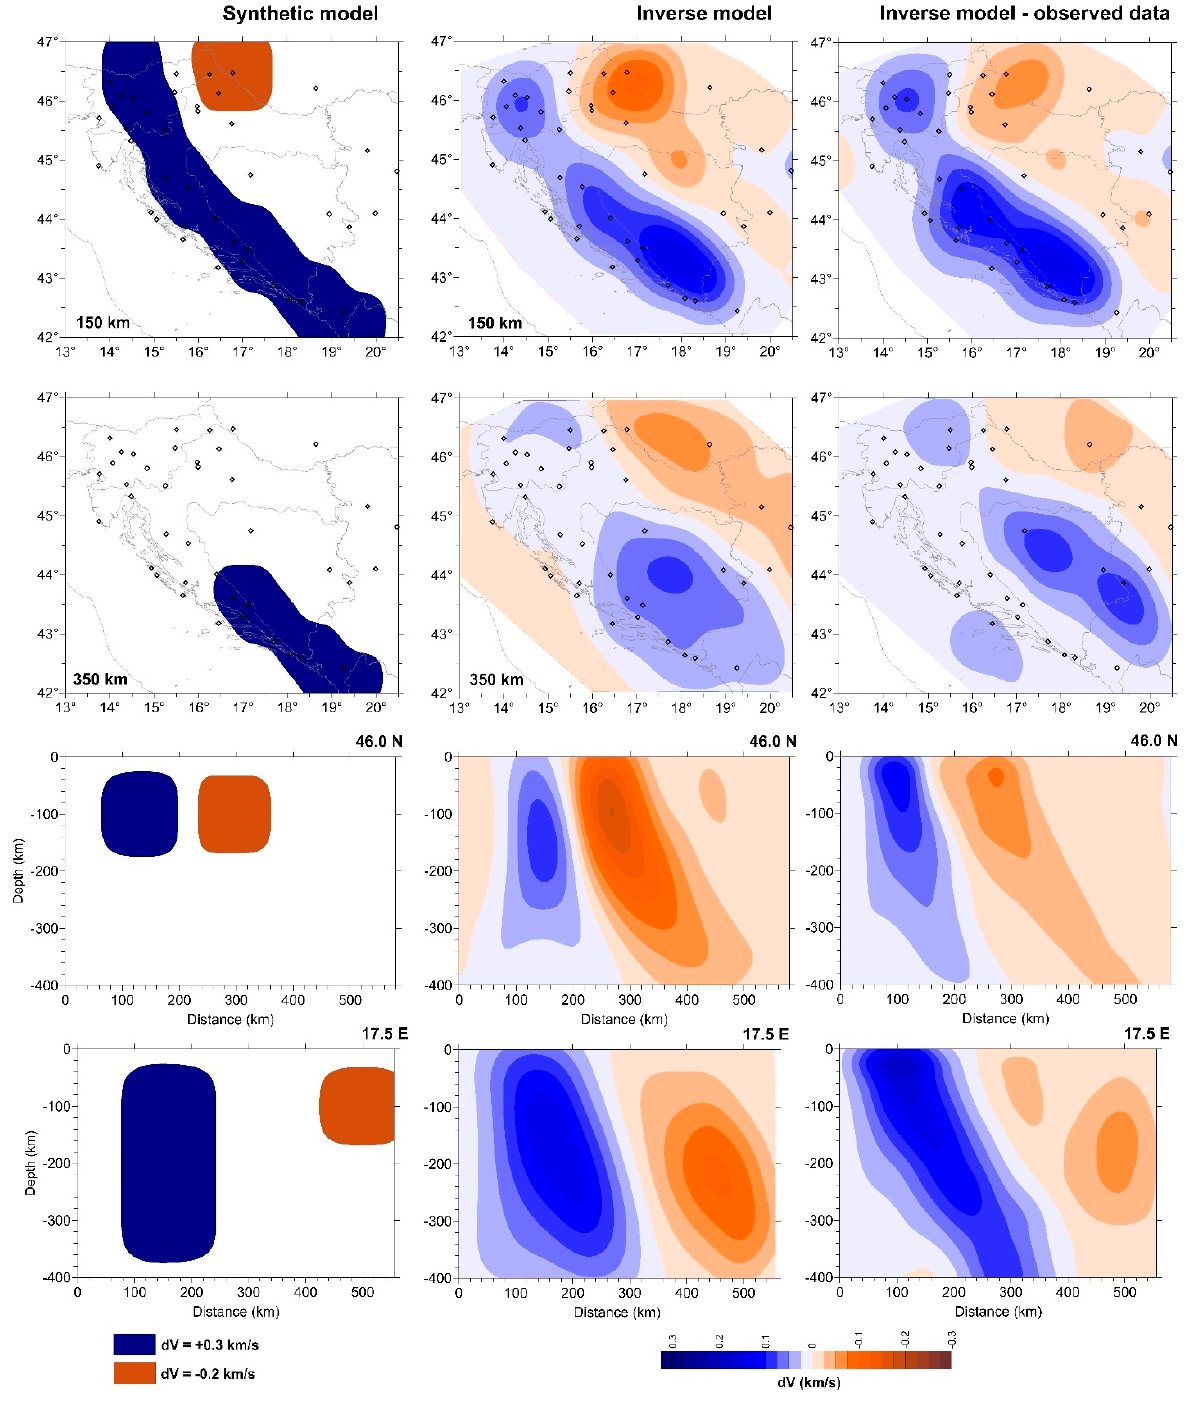
Figure 5. First model. Three-dimensional velocity models showing two depth slices (150 km and 350 km, upper part) and two cross sections (46 °N and 17.5 °E, lower part). A high-velocity vertical slab in the synthetic model is assumed (left side), where it is shallow in the Northern and deep in the Southern Dinarides. The inverse model recovered from synthetic travel-time residuals is shown in the middle part, and the inverse model of observed travel-time residuals in the SU-model [8] is shown on the right side. Additional low-velocity block is assumed in the Pannonian